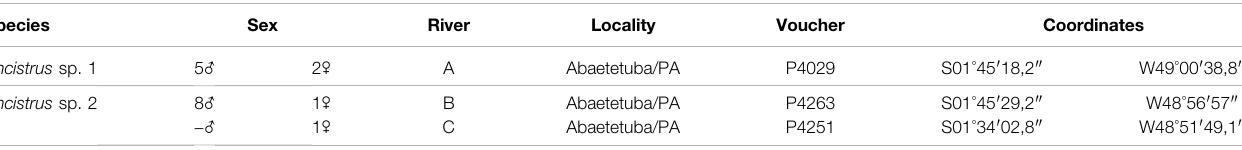
TABLE 1 | Sampling and collection sites of Ancistrus specimens analyzed in this study. Species Sex River